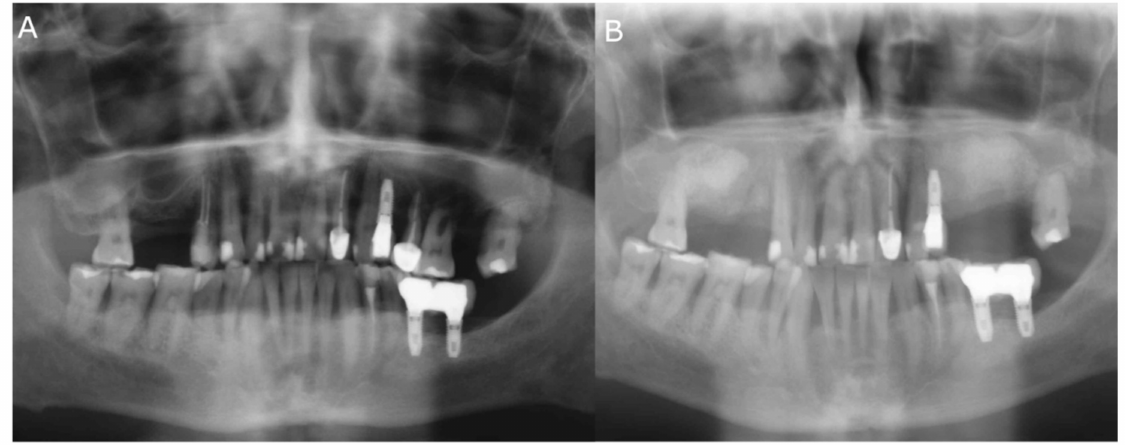
Figure 1. ( A ) Preoperative and ( B ) postoperative orthopantomography radiography after bilateral sinus lift using the lateral window approach